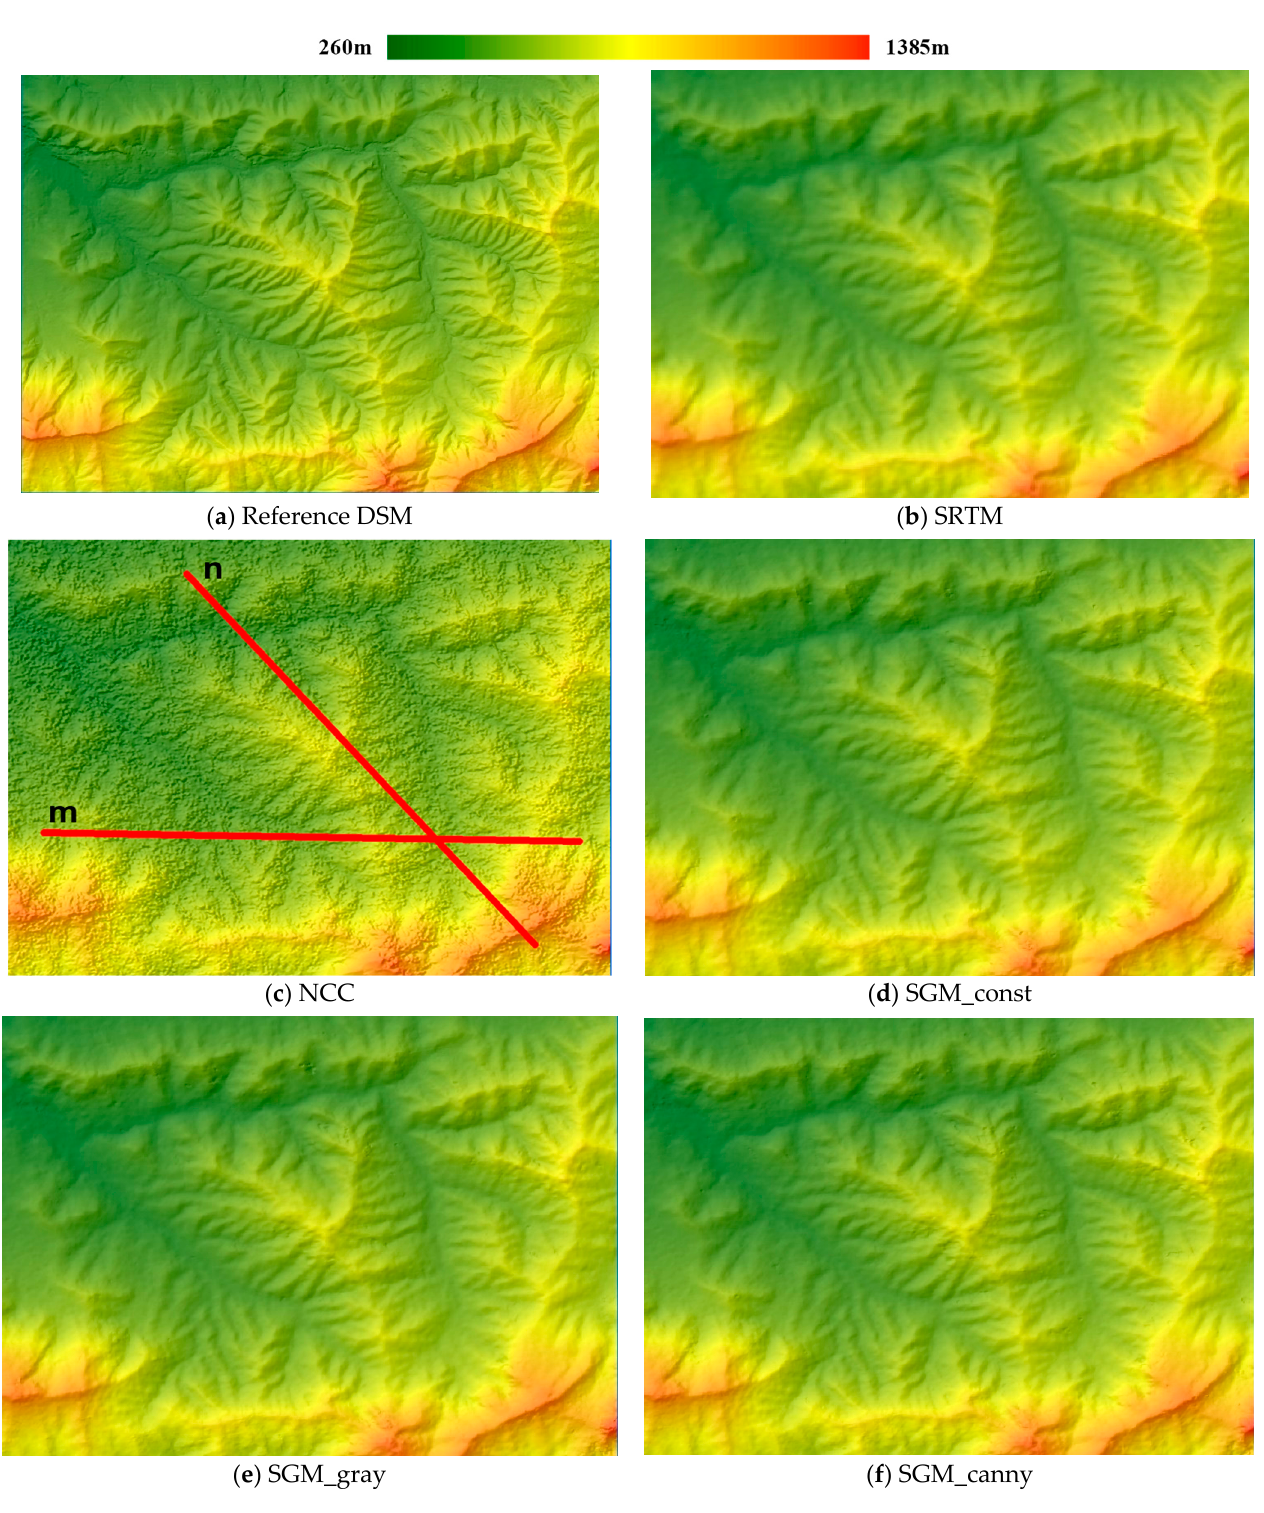
Figure 5. Hillshade of test area 1: ( a , b ) Hillshade of the reference photogrammetry DSM, and 30 m resolution SRTM DEM; ( c – f ) Hillshade of 10 m resolution radargrammetric DSMs produced from SM images by NCC, SGM_const, SGM_gray, and